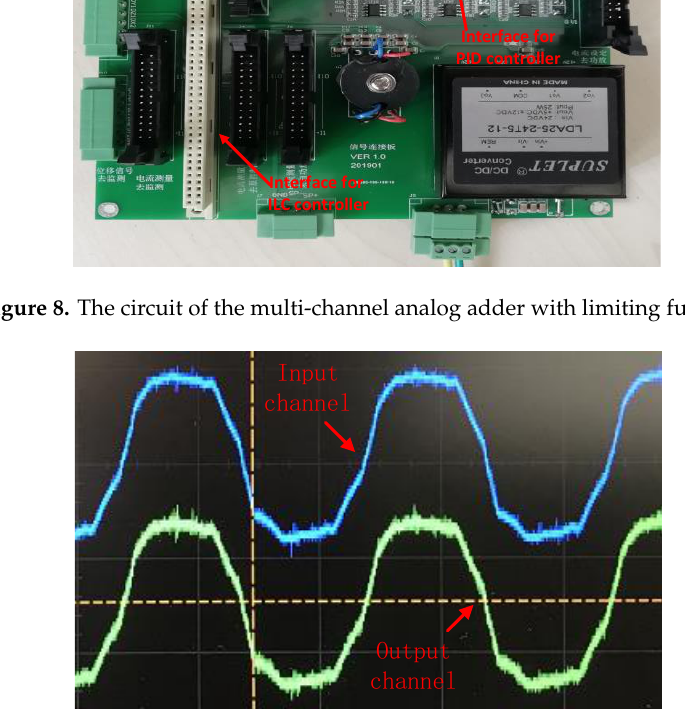
Figure 9. The conformance test results of the multi-channel analog